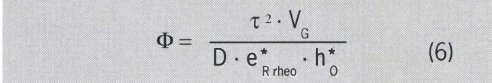
1 shows the rheological wear intensities (station­ ary phase) for two lubricating greases at varying shear rates. The assumption that, at high shear rates, one could also expect high wear intensities, was not con­ firmed. On the contrary, comparisons showed that the